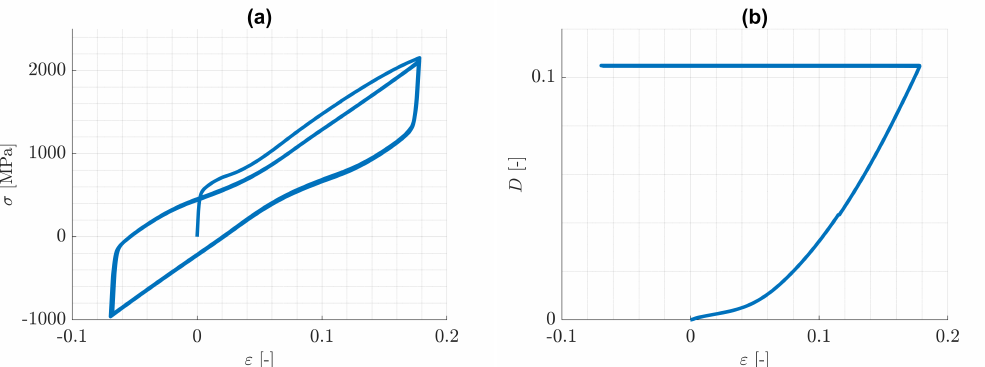
Figure 4. ( a ) ( ε 22 , σ 22 ) -distribution and ( b ) ( ε , D ) -distribution for the first integration point behind the crack tip.